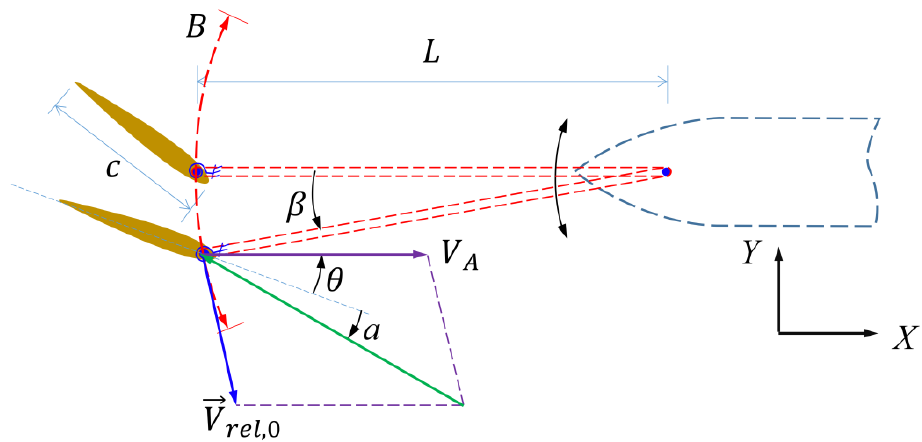
Figure 1. Simplified schematic of the semi-active flapping hydrofoil driven by the swing